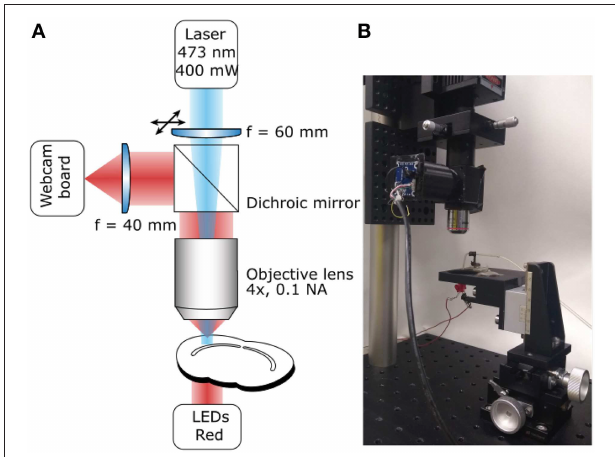
FIGURE 1 | Photoconversion Rig. (A) Diagram of the light path for both sample illumination (blue) and visualization (red). (B) Photograph of a working setup including sample illumination and visualization paths and sample